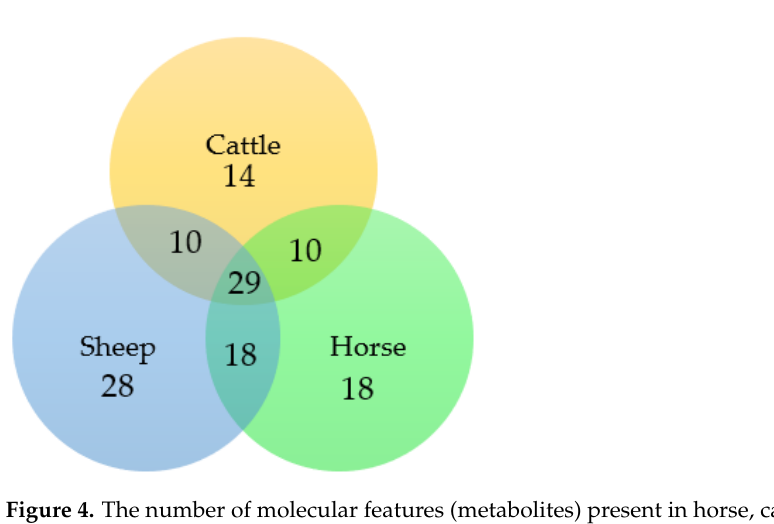
Figure 3. Representative gas chromatography/mass spectrometry total ion chromatograms of ( a ) horse dung, ( b ) sheep dung, and ( c ) cattle dung volatilomes.